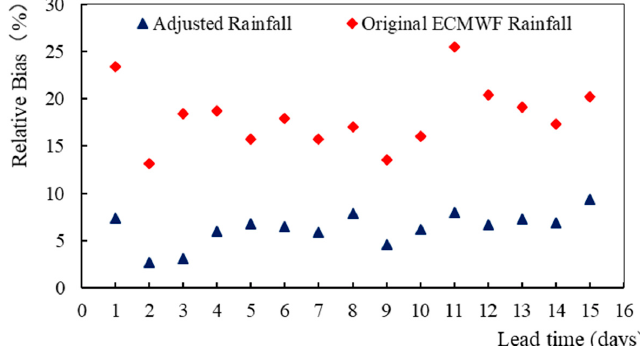
Figure 7. Relative bias of S2S ECMWF precipitation and the corrected precipitation in the validation period as function of forecast lead time.